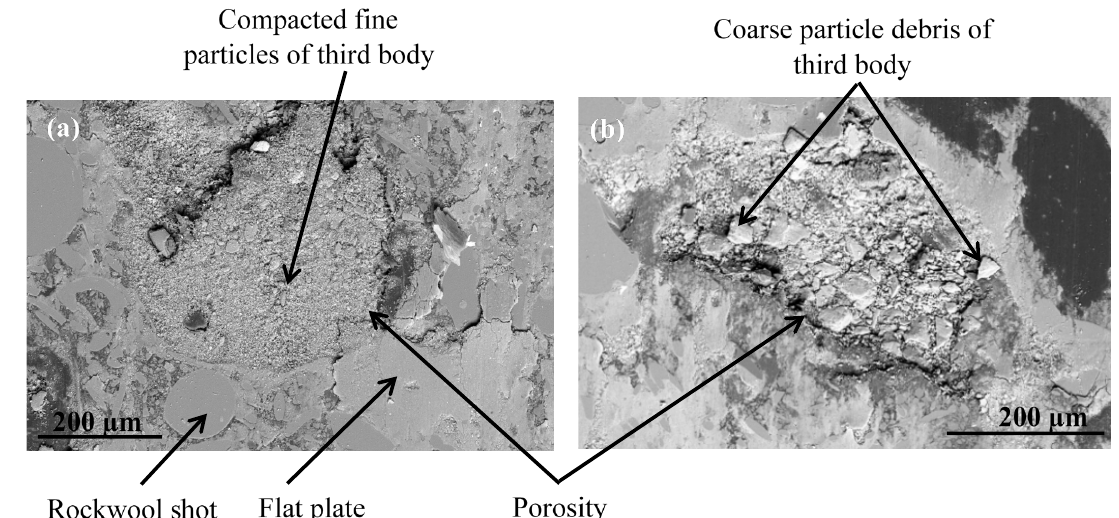
Figure 18. SEM micrographs of worn surfaces of ( a ) M1 and ( b ) M2 (BSE).